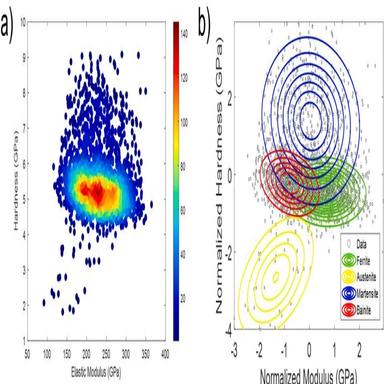
a) Modulus vs. Hardness plots elucidating the relationship between probed values in the mechanical properties space. b) 2D Gaussian representation of the PDA EM-optimized data fitting within the Hardness vs. Elastic Modulus (normalized values) space: the phase statistics are highlighted following Fig. 6 color coding.